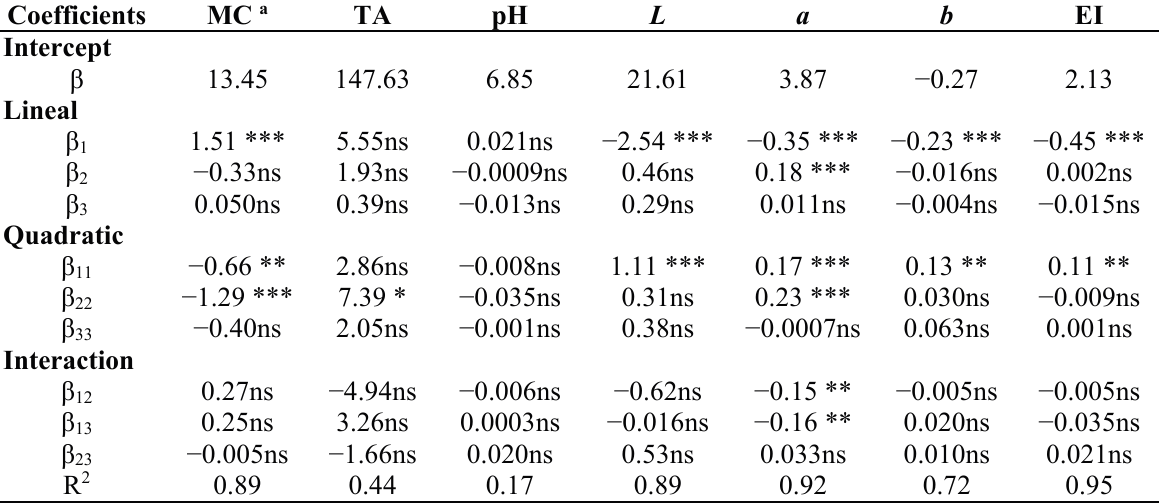
Table 1. Coefficients of the second order equations (prediction models), analysis of variance and determination coefficients, showing the relationship among the processing factors and the chemical and physical properties of the extrudates.